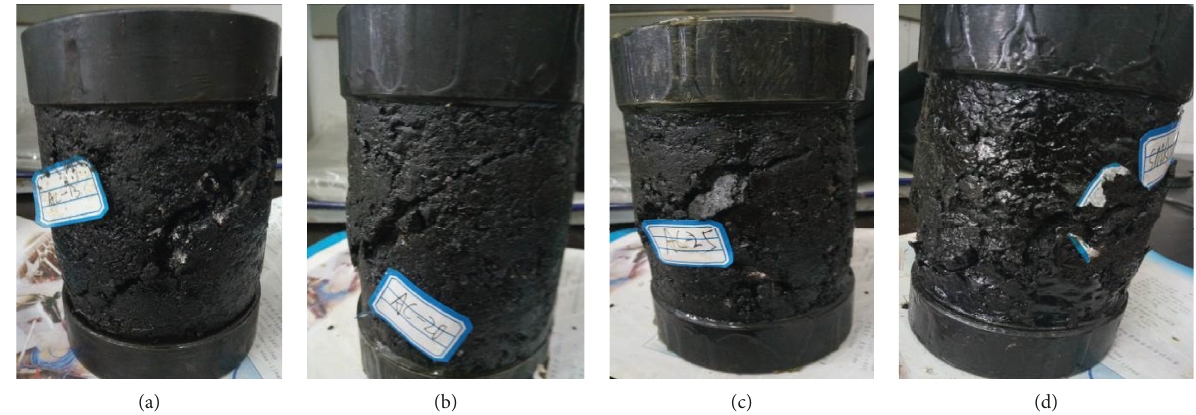
Figure 9: Specimens after destruction. (a) AC-13; (b) AC-20; (c) AC-25; (d) SMA-13.